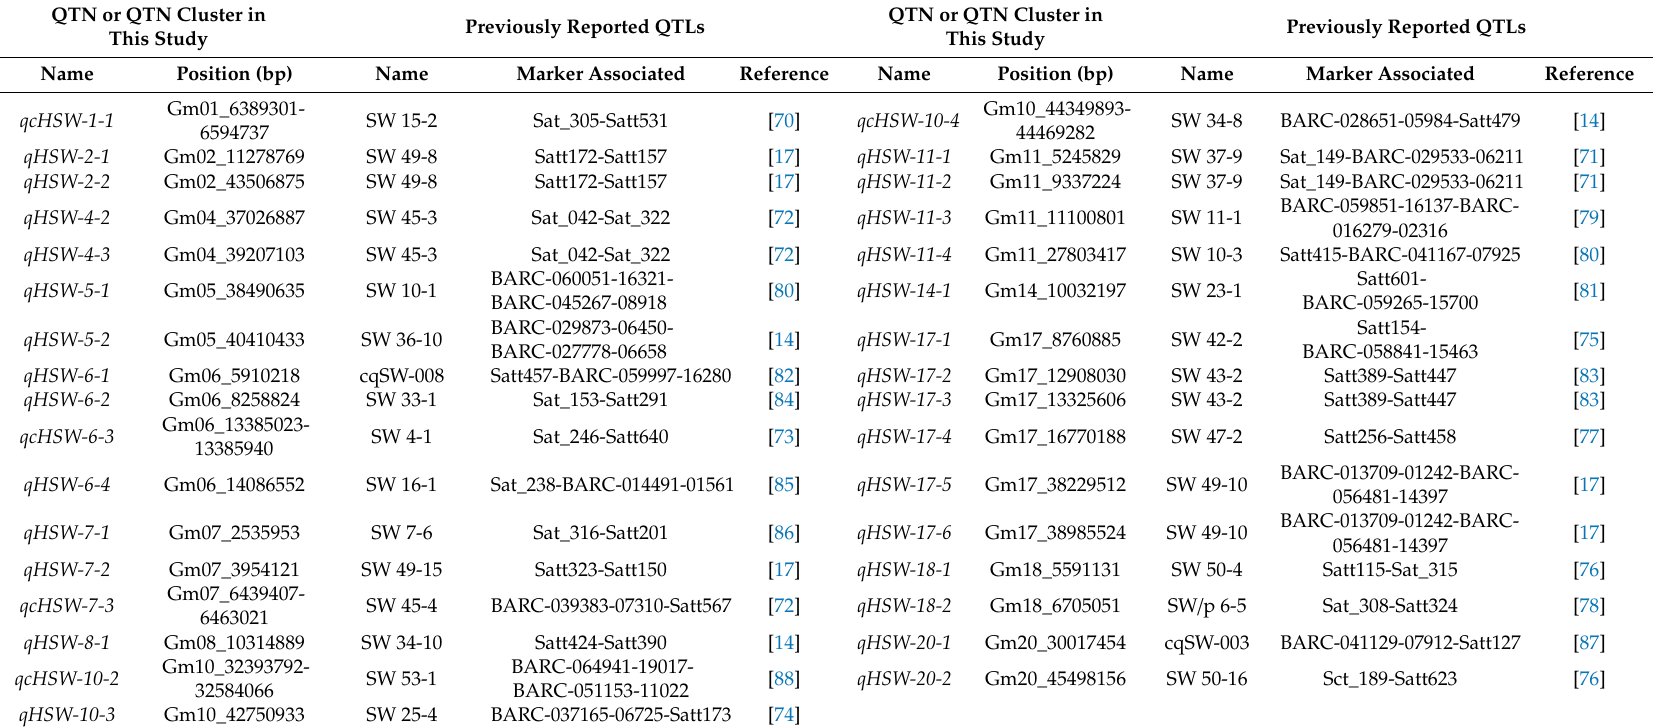
Table 6. Stable QTNs of soybean 100-seed weight in this study that are reported in previous